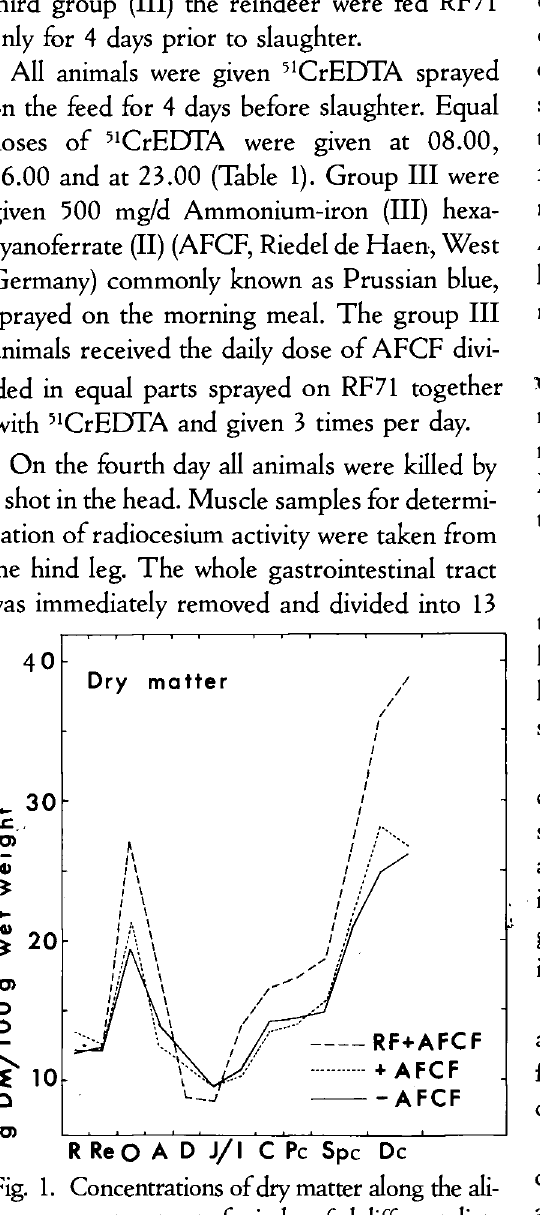
Fig. 1. Concentrations of dry matter along the ali mentary tract of reindeer fed different diets and with and without treatment with Ammonium-ironhexcyanoferrate (AFCF); RF fed RF71 and given 525 mg AFCF/d (n=3); +AFCF fed lichens and RF71 and given 500 mg AFCF/d (n=2); -AFCF fed lichens andRF71 (n=2). R, rumen; Re, re ticulum; O, omasum; A, abomasum; D, duodenum; J/I, jejunum/ileum; C, caecum; Pc, proximal colon; Spc, spiral colon; D, distal colon.